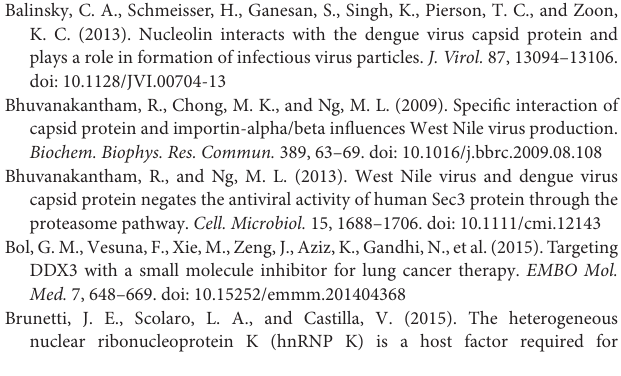
expression of recombinant His-tagged proteins were analyzed by western blotting with capsid antibody. GAPDH levels are shown as loading controls. Figure S4 | DENV infection downregulates DDX3X in Huh-7 cells at later stages of infection. (A) Huh-7 cells were infected at 1 MOI and fixed at 24 and 48h pi. Cells were stained for DDX3X (red), dengue envelope (green) and nuclei with DAPI (blue). (B) The fluorescence intensity of DDX3X staining was quantitated using Fluoview software. Quantitation of DDX3X fluorescence intensity (AU) at 24 and 48h pi. ( n = 15) ∗∗∗ P < 0.0005. Figure S5 | DDX3X downregulation enhances DENV infection in A549 cells. (A) Cells were transfected with si-NTC or si-DDX3X and at 48h p.t. knock-down efficiency was measured by real-time PCR from total RNA. (B) Cells transfected with si-NTC or si-DDX3X were infected with DENV at 3 MOI at 48h p.t. Viral titres were estimated at 24h pi by plaque assay and viral genome levels were analyzed by real-time and normalized to GAPDH (C) Data represents three independent experiments performed with triplicates samples ( n = 9). ( D) Viral entry was assessed in DDX3X knockdown cells. Cells were collected after 1h of virus adsorption and viral genome levels was analyzed by real-time PCR. Data presented are from two independent experiments performed with three replicates each ( n = 6). Data is represented as mean ± SEM. ∗∗ P < 0.005 and ∗∗∗ P < 0.0005, ns = not significant. Figure S6 | Overexpression of HA-DDX3X in Huh-7 cells inhibits virus replication. HA-DDX3X was transfected in Huh-7 cells, and at 24h p.t, cells were infected with DENV at 3 MOI and viral titers were measured by plaque assay at 24h pi (A) DENV viral genome levels were estimated by real-time PCR. Data is from three independent experiments performed in triplicates ( n = 9). (B) Data is represented as mean ± SEM. ∗∗ P < 0.005. Figure S7 | Gating strategy for dengue infection in GFP-DDX3X transfected cells. HEK293T cells transfected with GFP-DDX3X constructs were infected with DENV2 at 5 MOI at 24h pt. At 24h pi, cells were fixed and stained with APC-conjugated anti-DENV envelope antibody. Single cell population was gated in FSC-H vs. FSC-A plot and SSC-A vs. FSC-A plot. Live cells were gated for analysis. Dengue-E positive cells were gated in total GFP, GFP low and GFP high respectively. Figure S8 | Overexpression of HA-DDX3X and GFP-DDX3X. HA- or GFP-tagged DDX3X constructs were transfected in HEK-293T cells and at 48h p.t, cells were fixed and HA-DDX3X transfection samples were stained with HA antibody followed by secondary antibody conjugated with Alexa-488. Nuclei was stained with DAPI. Figure S9 | Overexpression of DDX3X plasmids does not affect cell viability. GFP-tagged DDX3X constructs were transfected in HEK-293T cells and at 24h p.t, cells were infected with DENV at 5 MOI. (A–D) The fixable live-dead viability stain (BD EF-780) was added at 1:1000 dilution and incubated at RT for 10min and then washed with FACS buffer. Cells were processed by flow cytometry. Figure S10 | IFN- β levels in Huh-7 in DDX3X knockdown and DENV infection. siRNA knockdown of DDX3X was done in Huh-7. Forty-eight hour p.t, cells were either mock or DENV infected at 10 MOI. Twenty-four hour p.i the IFN- β mRNA levels were assessed by real-time PCR. Data is represented as mean ±